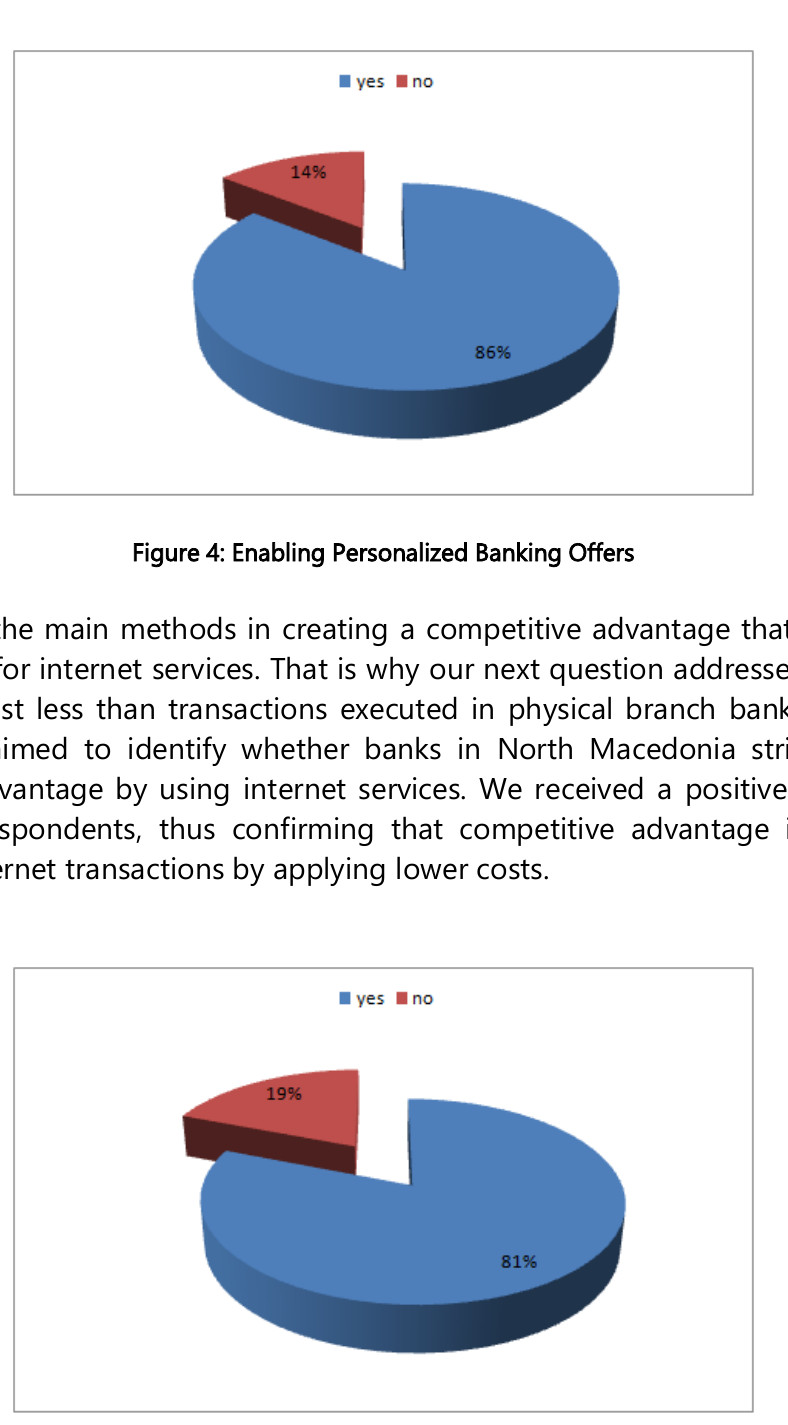
Figure 5: Lower Internet